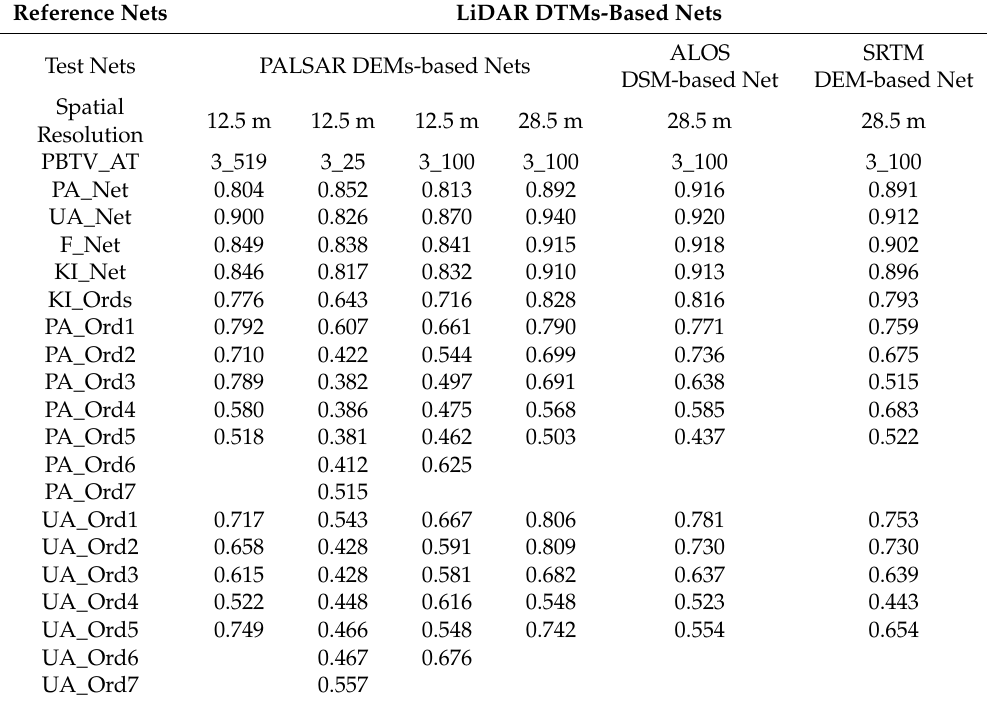
Table 9. Performance metrics computed based on the comparison between networks/orders extracted from LiDAR DTMs and global DEMs at different ATs expressed in the corresponding number of pixels, PBTV in pixels, and spatial resolution in